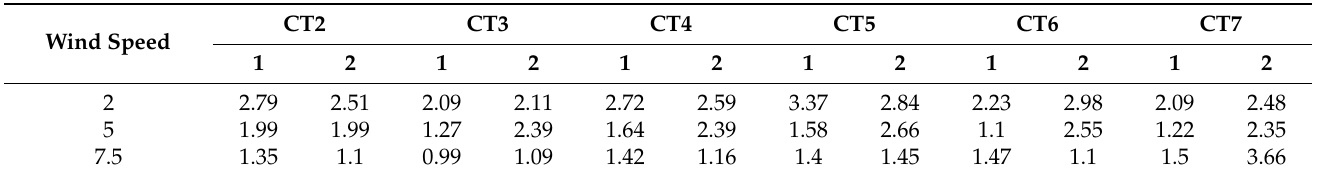
Table 15. Wind speed and diurnal (1) and nocturnal (2) temperature difference in compact-type arrangements.